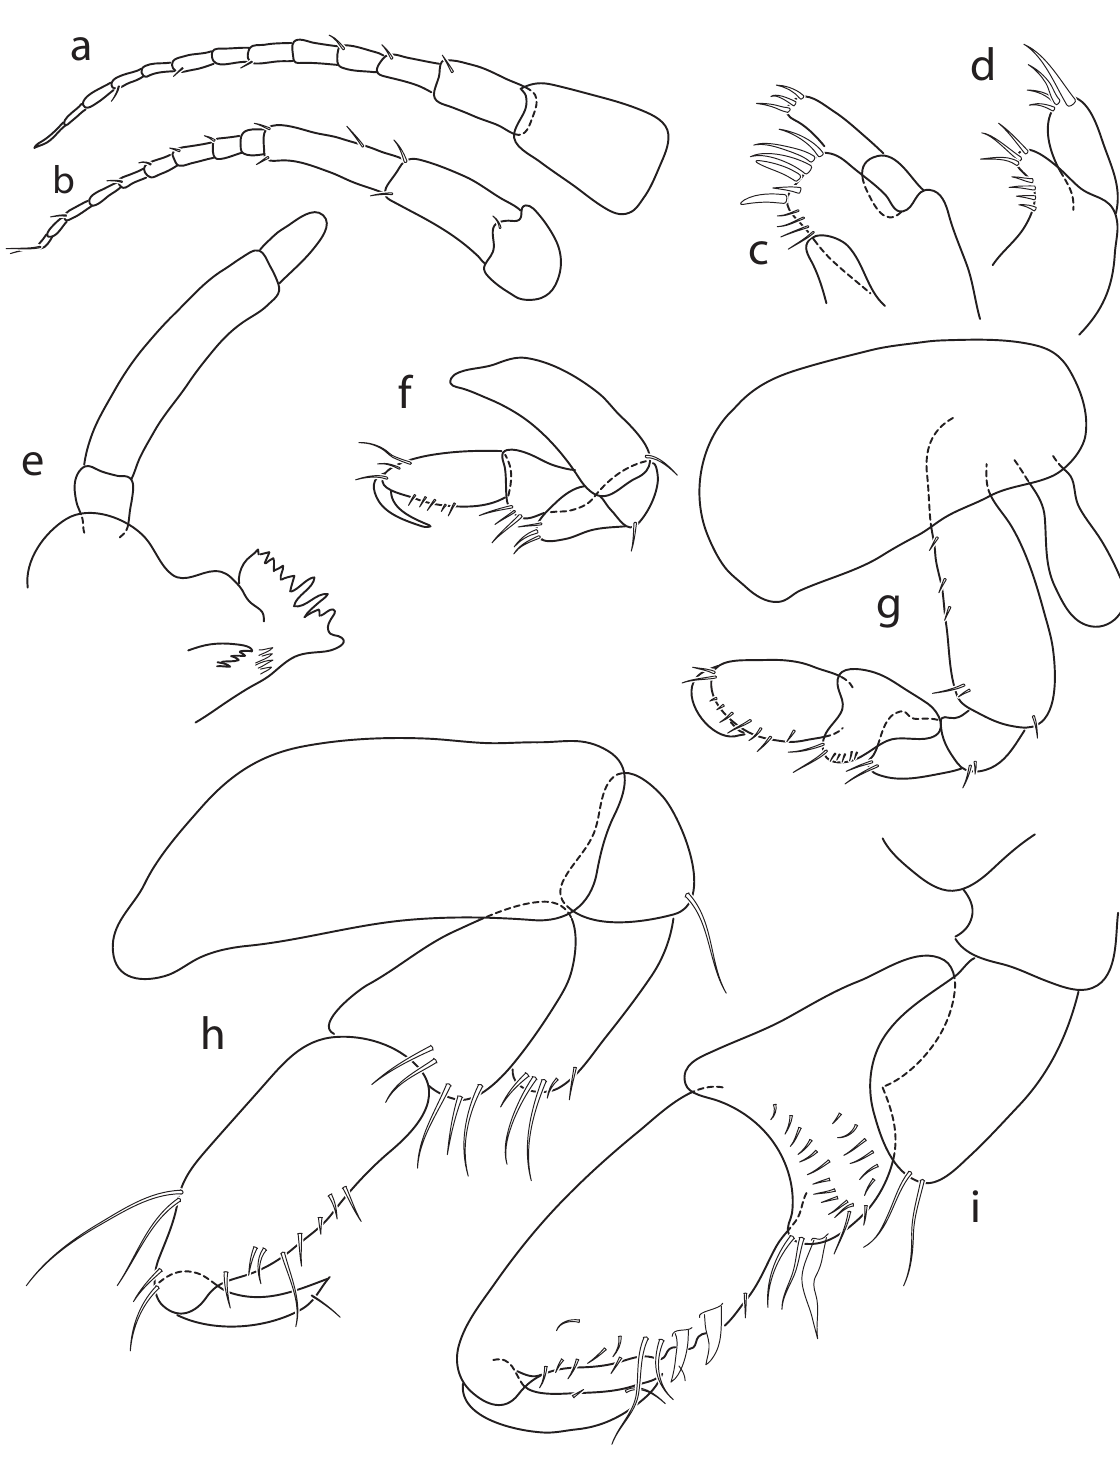
Fig. 27. Torometopa cf. crassicornis (Schellenberg, 1931) . a . Antenna 1. b . Antenna 2. c . Maxilla 1. d . Maxilla 2. e . Mandible. f . Gnathopd 1. g . Gnathopod 2. h . Gnathopod 1, enlarged. i . Gnathopod 2, ischium to dactylus, also enlarged. Figure not